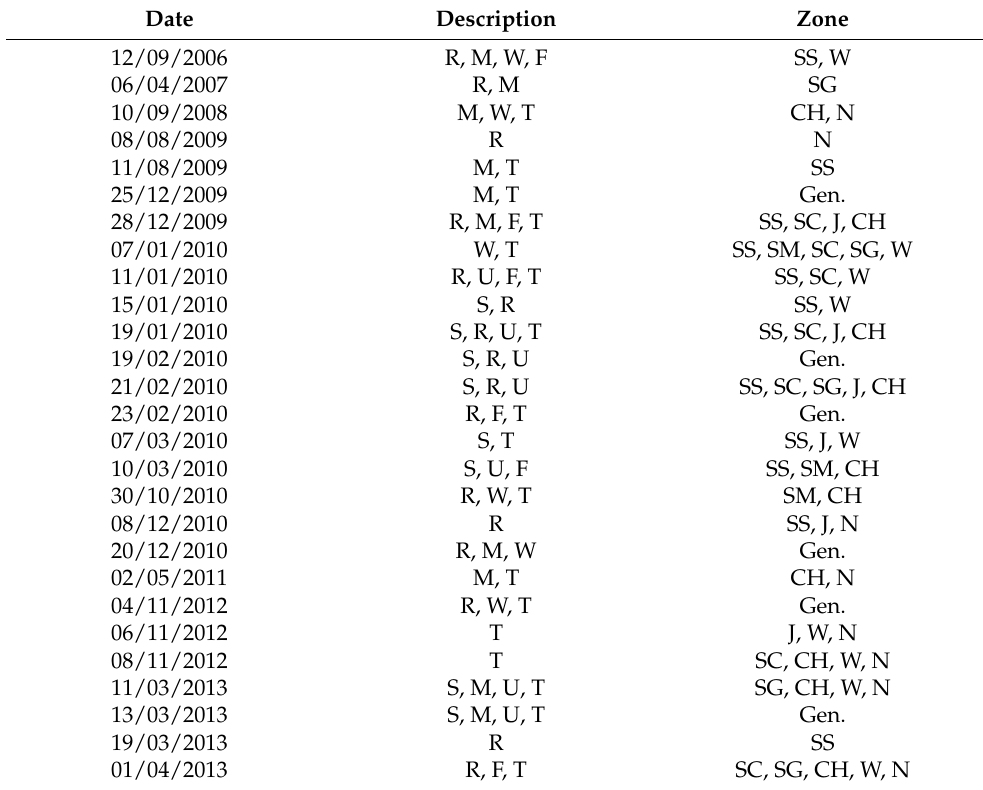
Table 1. News about incidences registered in the local media: S, slides; R, (rock)falls; M, mud and earth; U, road undercut; W, water, F, floods; T, traffic cuts. Sectors: SS, Sierra Sur; SM, Sierra M á gina; SC, Sierra Cazorla; SG, Sierra Segura; J, Ja é n (capital city); CH, Central Hills; W, Western sector; N, Northern sector; Gen.,